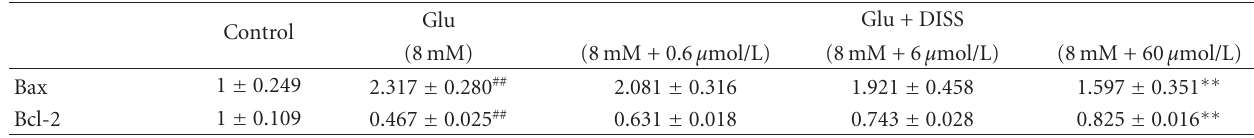
Table 1: E ff ect of DISS on Bax and Bcl-2 expression in SH-SY5Y cells after Glu exposure. β -actin was used as an internal control. Results are from three independent